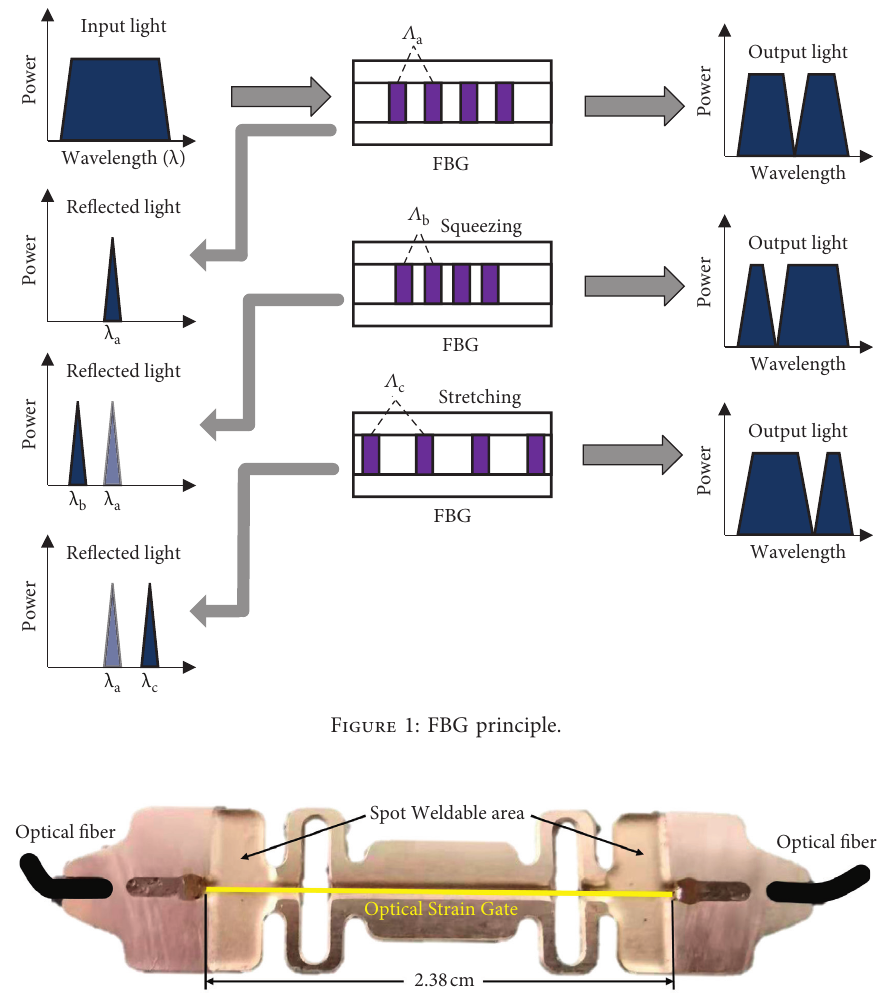
Figure 2: Deformation